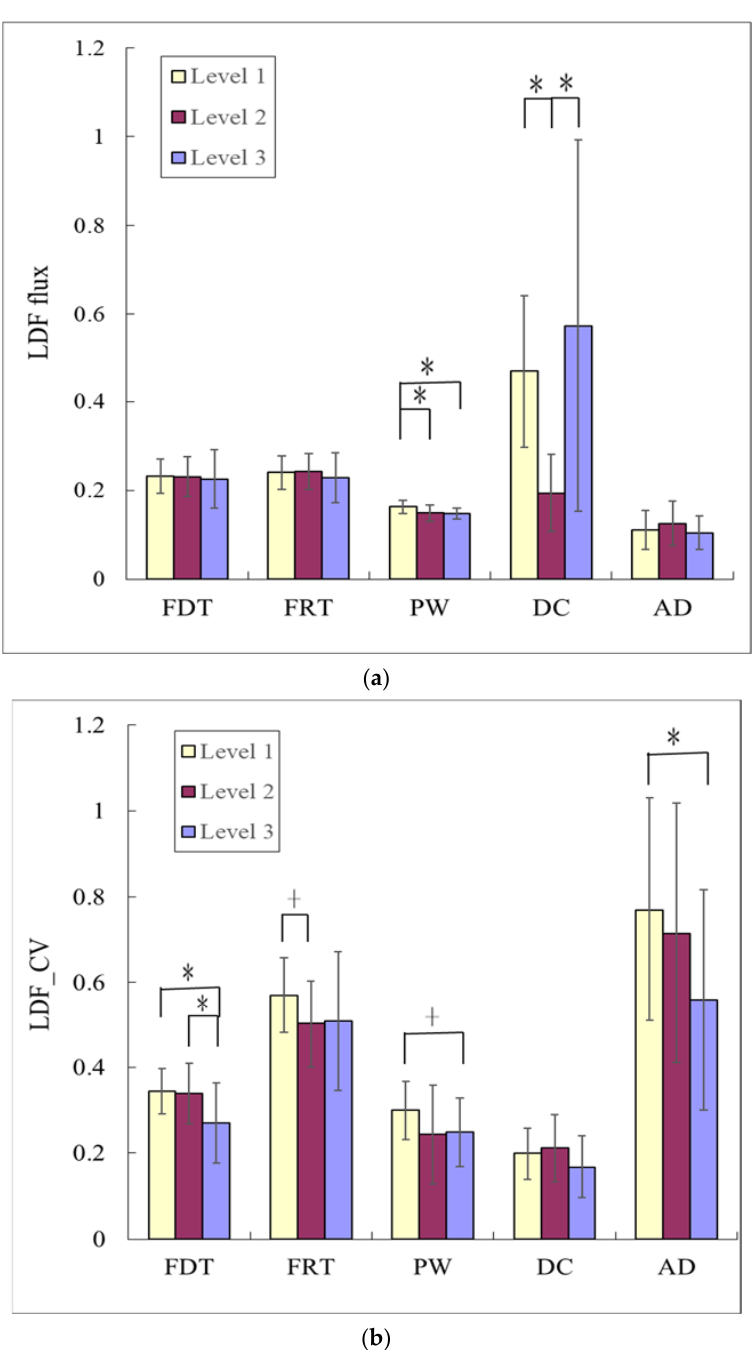
Figure 5. Comparisons of LDF ( a ) flux and ( b ) variability indices among the three groups. Data are mean and SD values. “*” indicates p < 0.05; “+” indicates 0.05 < p < 0.1. ( a ) For the LDF flux indices, PW was significantly larger in Level 1 than in Level 3 and Level 2, and DC was significantly smaller in Level 2 than in Level 3 and Level 1. ( b ) For the LDF variability indices, FDT_CV was significantly larger in Level 1 and Level 2 than in Level 3, and AD_CV was significantly larger in Level 1 than in Level 3.